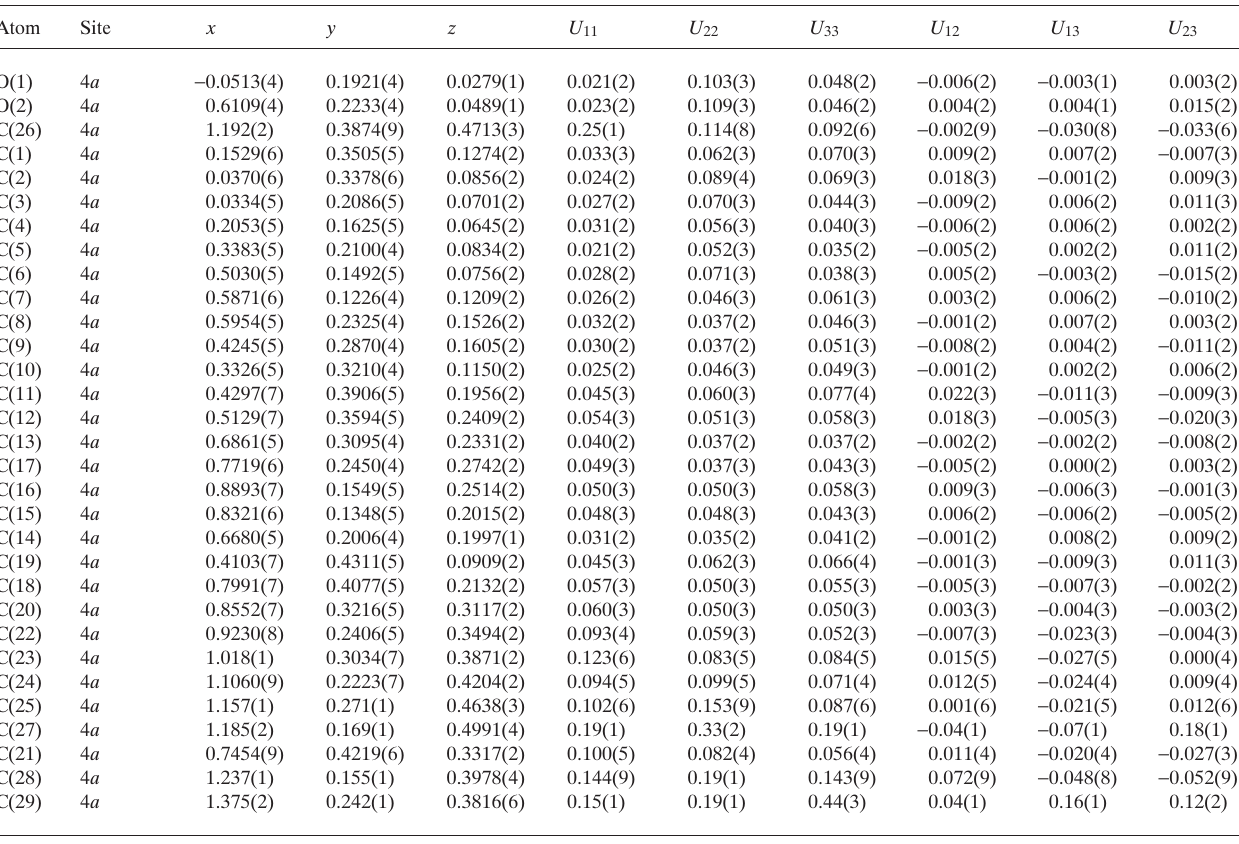
Table 3. Atomic coordinates and displacement parameters (in Å 2 )